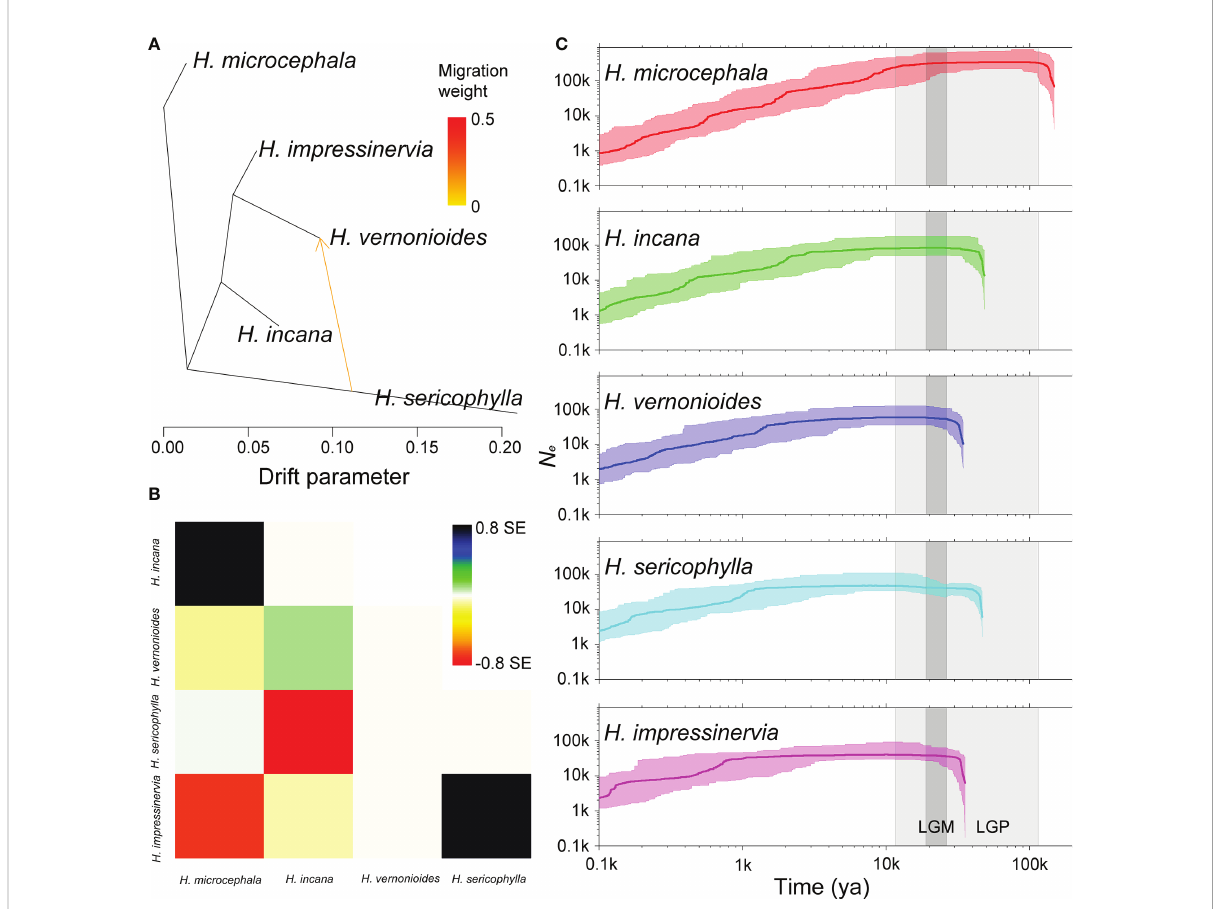
FIGURE 5 Interspeci fi c gene fl ow and demographic history of Heteroplexis. One gene fl ow event inferred by Treemix (A) and the corresponding residual plot (B) . (C) Estimates of the effective population size ( N e ) using Stairway Plot. Thick and thin light lines represent the median and the 95%